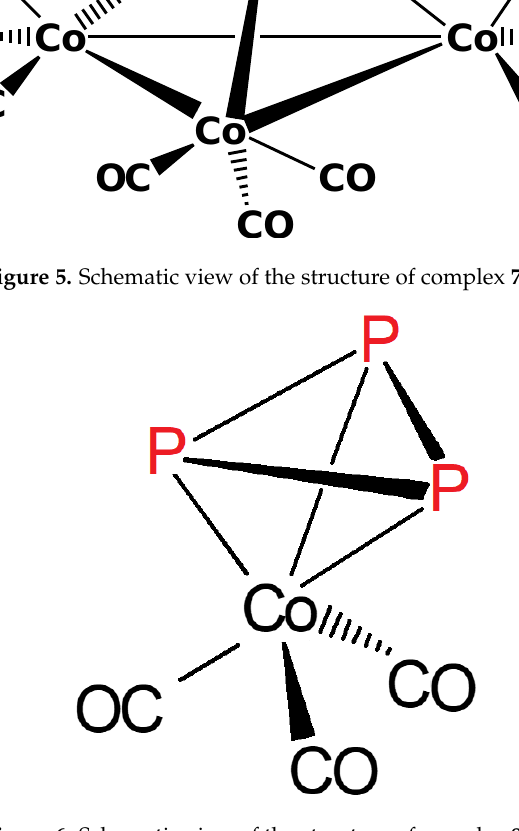
Figure 6. Schematic view of the structure of complex 8 [33].